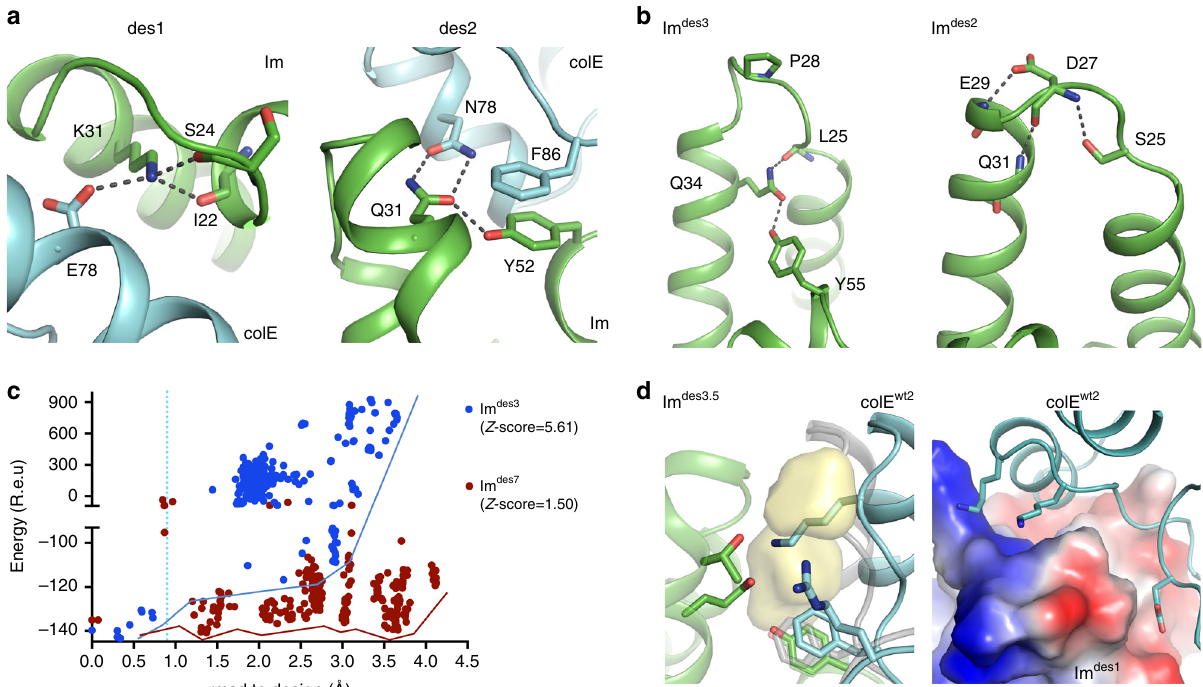
Fig. 6 The structural basis of speci fi city and multispeci fi city among designed pairs. a Structure models show high polarity in designed, high-speci fi city interfaces. Im des1 buries positively charged Lys31 at the interface, which is compensated by negatively charged Glu78 on the cognate colE des1 and by hydrogen bonding to backbone atoms on Im loop I. colE des2 /Im des2 interact through a hydrogen-bond network that involves hotspot residue Tyr52. b , c Im Loop I preorganization predicts Im speci fi city. b Structure models show that stabilizing interactions within loop I of the high-speci fi city designs preorganize the loop I backbone in the designed conformation. Loop I of Im des3 is con fi gured by Pro28 and side chain-backbone hydrogen bonds. Loop I of Im des2 is stabilized by a network of side chain-backbone polar interactions. c Modeling the sequence of the high-speci fi city Im des3 on alternative backbone conformations observed in the Protein Data Bank converges on low-energy conformations only in the vicinity of the designed backbone conformation (blue; vertical cyan line at 0.9Å rmsd). Models of the multispeci fi c Im des7 , by contrast, diverge to multiple minima away from the designed conformation (red). Z - scores indicated in parentheses. d Models of the relaxed non-cognate colE/Im pairs suggest that low binding af fi nity results from cavities, electrostatic repulsion and unsatis fi ed polar atoms at the interface. The model of colE wt2 /Im des3.5 (left), with K D ≥ 100,000 nM, shows a large cavity (yellow) in loop I region and reorientation of the hotspot Phe86 (cognate colE des3 orientation in gray). Model of colE wt2 /Im des1 (right), with K D ≥ 100,000 nM, shows positively charged Lys on colE wt2 that faces the positively charged loop I region on Im des1 (surface colored according to the electrostatic potential), and a negatively charged Glu that faces a surface of the same charge on helix II of Im des1 . The computed binding energies for these non-cognate interactions are poor ( − 12.4 Rosetta energy units [R.e.u] for colE wt2 /Im des3.5 and − 15.8 R.e.u for colE wt2 /Im des1 ) compared to tight binding of the cognate colE des3.5 / Im des3.5 , colE des1 /Im des1 , and colE wt2 /Im wt2 counterparts ( − 36.0, − 39.9, and − 34.6 R.e.u,